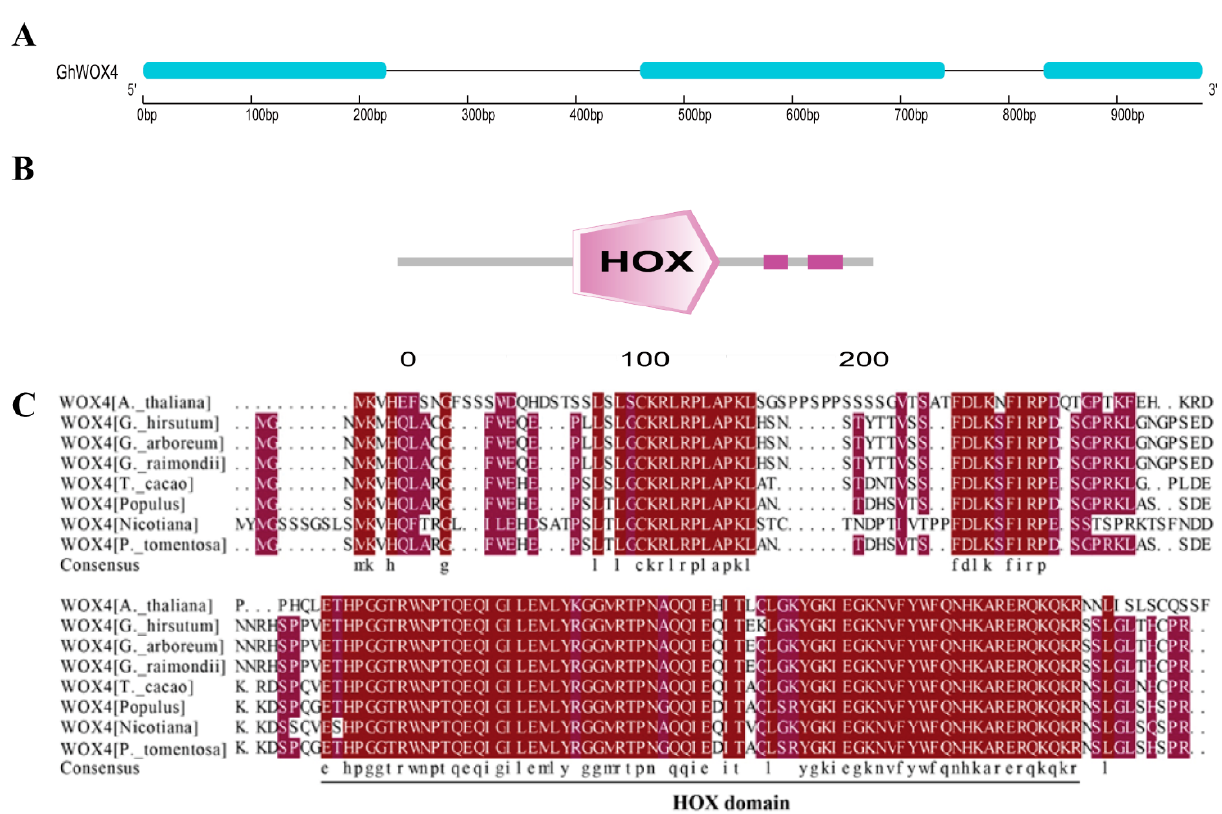
Figure 1. GhWOX4 domain and sequence alignment. ( A ) Gene structure: solid blue lines indicate exons, and black lines indicate introns. ( B ) Protein domain. ( C ) Protein sequence comparison of different plant species, Arabidopsis thaliana , Gossypium hirsutum , Gossypium arboreum , Gossypium raimondii , Theobroma cacao , Populus trichocarpa , Nicotiana benthamiana and Populus tomentosa .